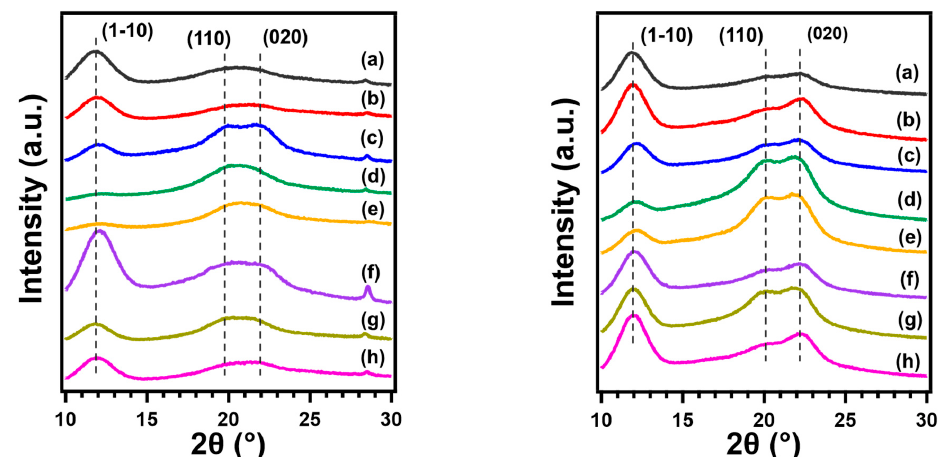
Figure 4. XRD spectra of regenerated cellulose films prepared from CNF ( left ) and MCC ( right ) through coagulation using ( a ) 5 wt% H 2 SO 4 and 5 wt% Na 2 SO 4 aqueous solution, ( b ) H 2 O, ( c ) ethylene glycol, ( d ) methanol, ( e ) ethanol, ( f ) 1 ‐ butanol, ( g ) acetone, and ( h ) n ‐ hexane.